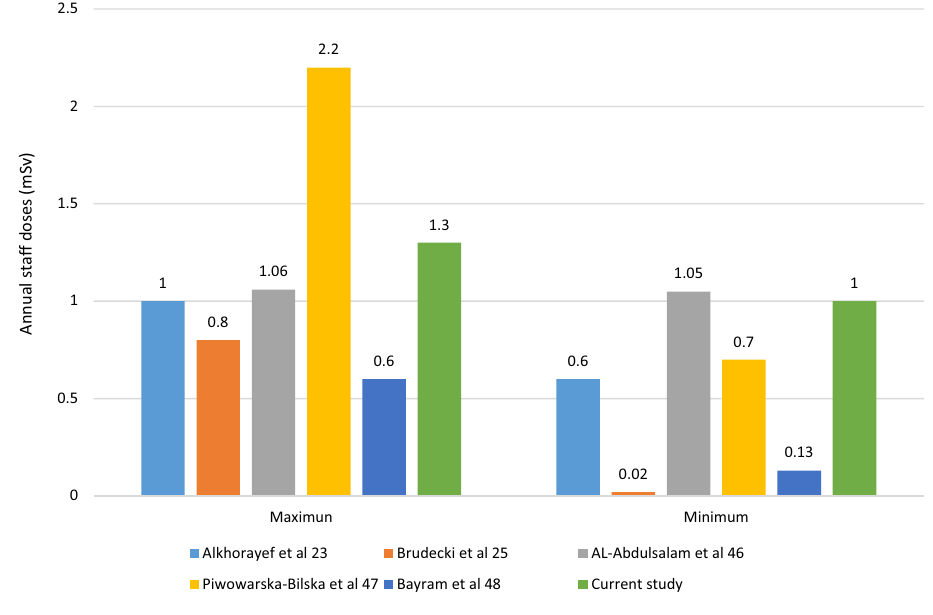
Figure 2. Occupational exposures compared to that recorded in previous